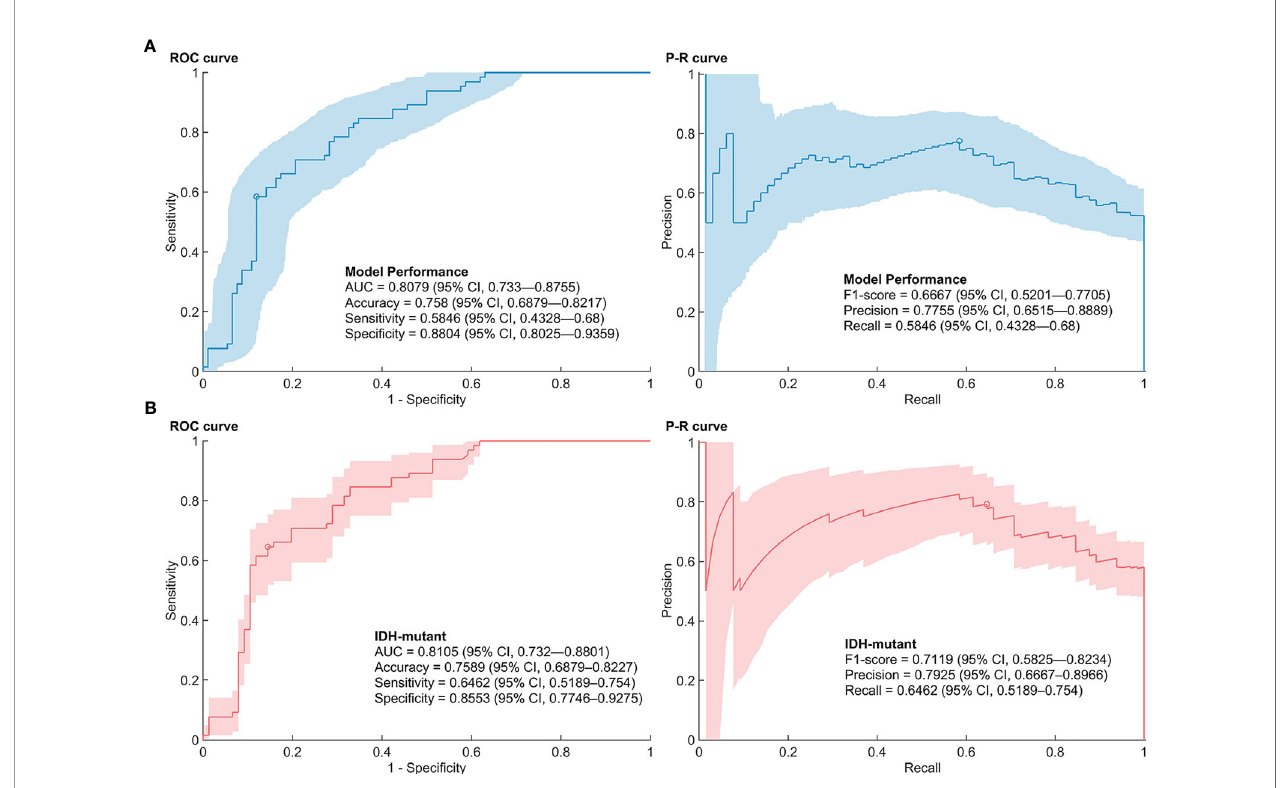
FIGURE 2 | Performance of 1p/19q co-deletion predictive models. (A) Receiver operating characteristic (ROC) curve and precision-recall (P-R) curve of the predictive models in low-grade gliomas. (B) ROC curve and P-R curve of the predictive models in low-grade gliomas with mutant